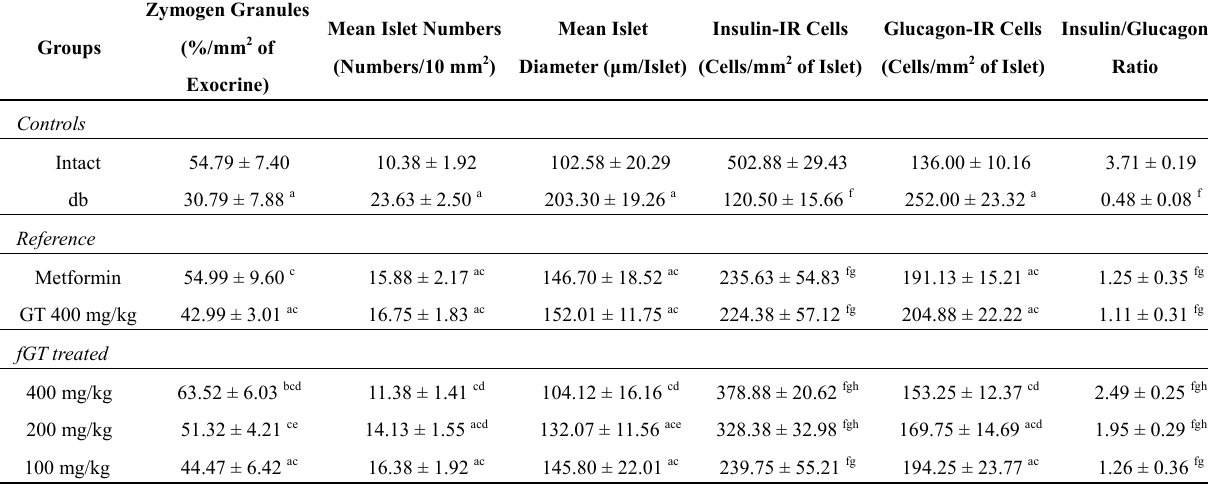
Table 7. Changes on histopathology-histomorphometry of the pancreas in intact normoglycemic and db/db